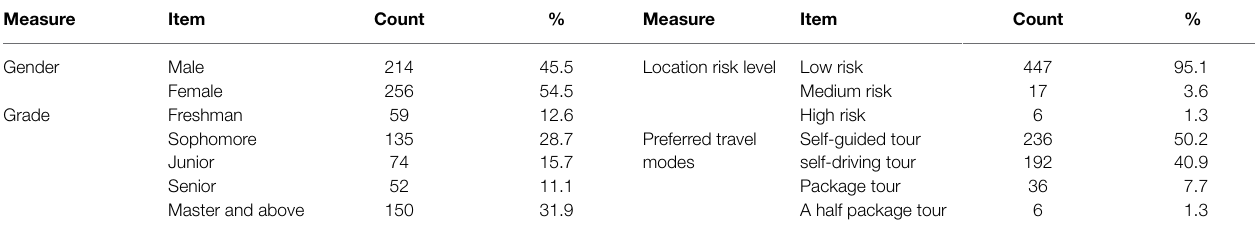
TABLE 2 | Descriptive statistics ( N = 470).